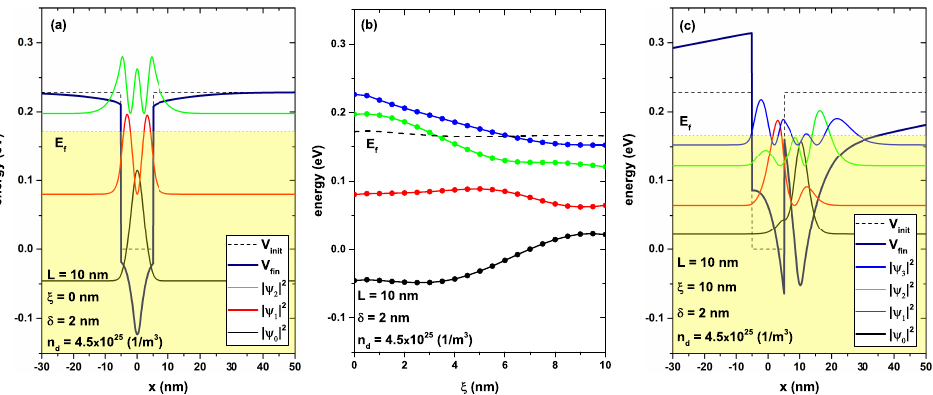
Figure 7. ( a , c ): Self-consistent potentials V ( x ) with a solid line in navy color, and electron confinement potential V c ( x ) in black dashed line. Figure ( a ) corresponds to ξ = 0 and Figure ( c ) to ξ = 10nm. For both figures, the parameters L = 10nm, n d = 4.5 × 10 25 (1/m 3 ), and δ = 2nm were set. In both figures, the probability densities of some confined states were included. The shaded region indicates the occupied states and the maximum of this region corresponded to the energy Fermi level. Figure ( b ) represents the lowest confined energy levels as a function of the ξ -parameter; the dashed line is the self-consistent Fermi level E f